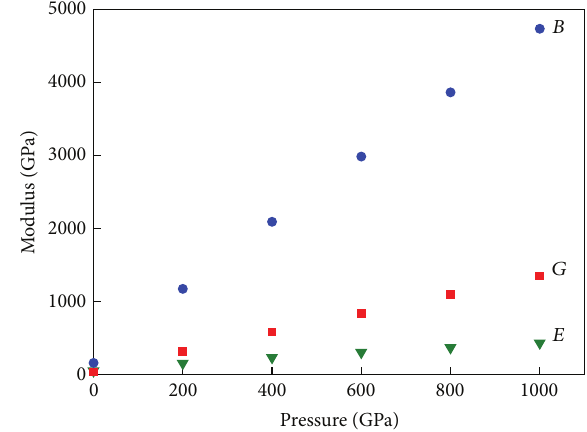
Figure 4: Bulk modulus, shear modulus, and young modulus of Au as a function of studied pressure range.